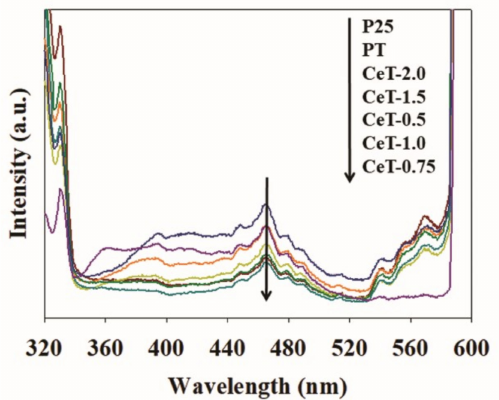
Figure 8. Photoluminescence spectroscopy (PL) profiles of Degussa P25 TiO 2 (P25), pure TiO 2 (PT), and Ce-doped TiO 2 catalysts with di ff erent Ce contents (CeT-0.5, 0.75, 1.0, 1.5, and